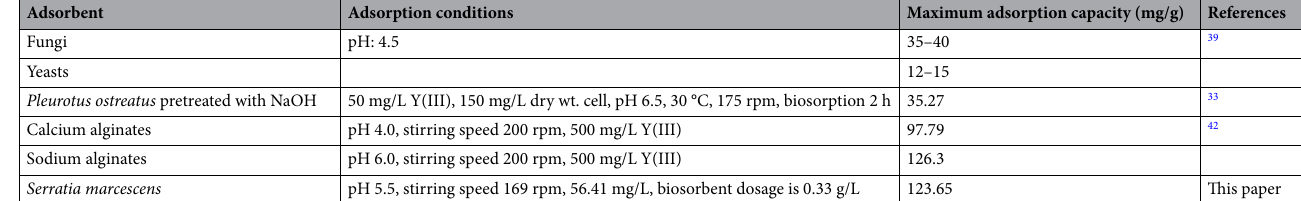
Table 3. Comparation of the maximum adsorption capacity of biosorbents for Y(III) in the literatures and the current